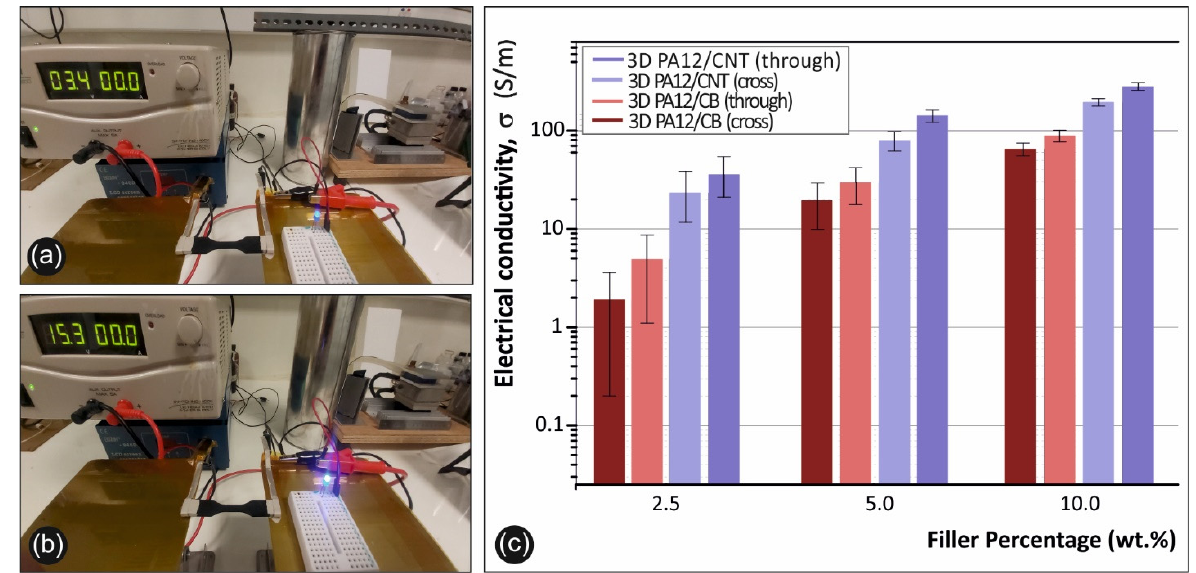
Figure 7. ( a , b ) Operation of an LED device when current is passing through a 5.0 wt.% filled PA12/MWCNT nanocomposite in a closed circuit, upon applying two different magnitudes of V bias , namely, 3.4 V and 15.3 V.; ( c ) electrical conductivity of the 3D ‐ printed PA12 conductive nanocomposites at 2.5, 5.0, and 10.0 wt.% MWCNT and CB contents, at two different measurement directions, namely, the “through layer” and the “cross layer” of the 3D ‐ printed object.